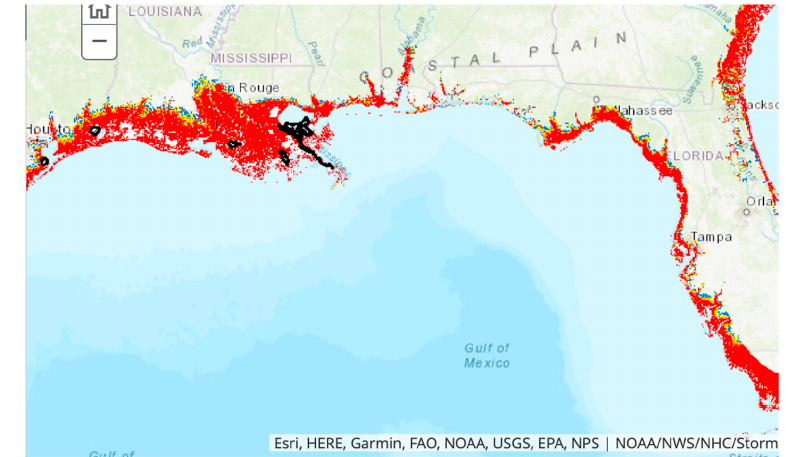
Figure 3. National Hurricane Center SLOSH predictions of the “maximum of maximum envelopes of water” (MOMS) caused by storm surges associated with landfalling Category 5 hurricanes on the central and eastern regions of the Gulf Coast (see https://www.nhc.noaa.gov/). The red areas could expect inundation to exceed 9 feet (~3 m) above existing ground levels. Levees currently protect areas shown in black.